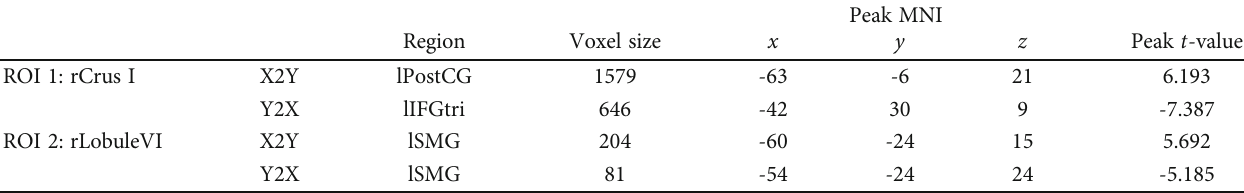
Table 5: Regions with signi fi cant between-group di ff erences in GCA (patient > control).